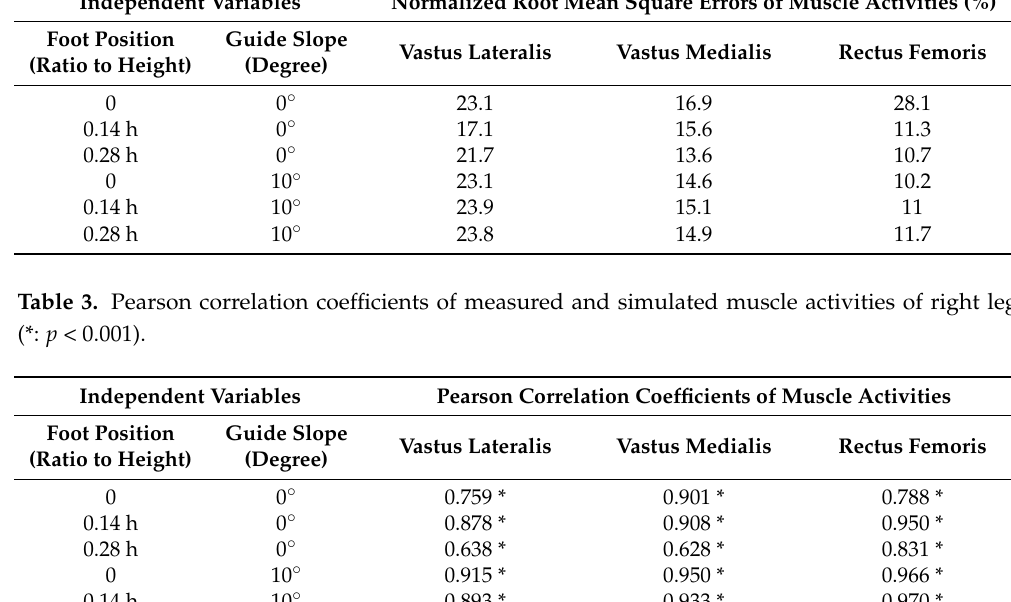
Table 4. Peak timing of maximum muscle activates of right leg measured by EMG sensors and simulated by AnyBody.